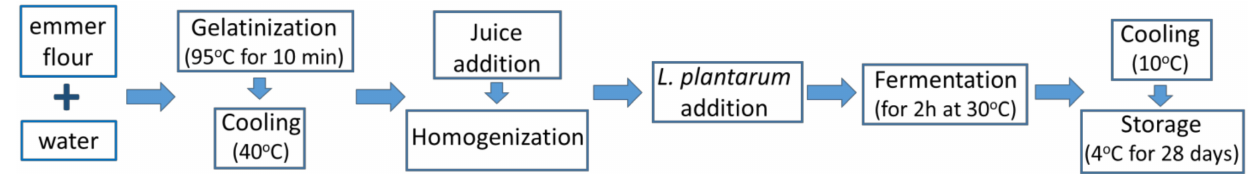
Figure 1. Protocol for the manufacture of beverages supplemented with juices from grapes and